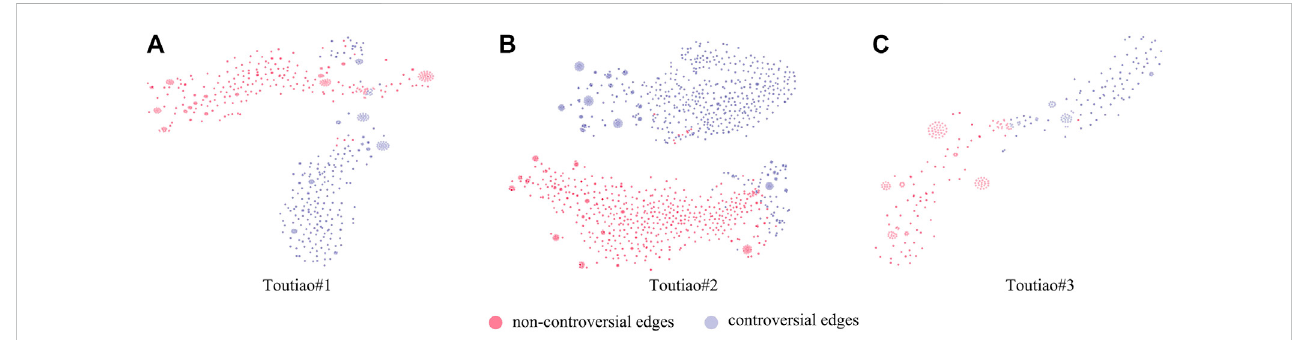
FIGURE 7 Comment-embeddings visualization. (A – C) represent the results of these three subsets: Toutiao#1, Toutiao#2 and